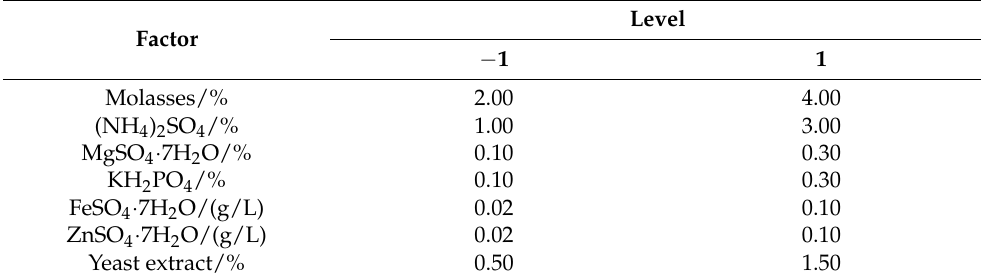
Table 1. Levels of the factors tested in the PB design.